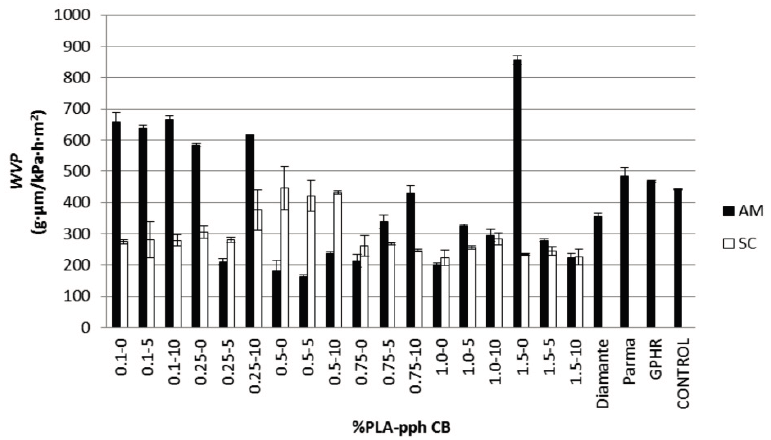
Figure 3. WVP (water vapor permeability) for the whole experimental design. Reference papers are included. Control corresponded to base cellulose paper of the packages.